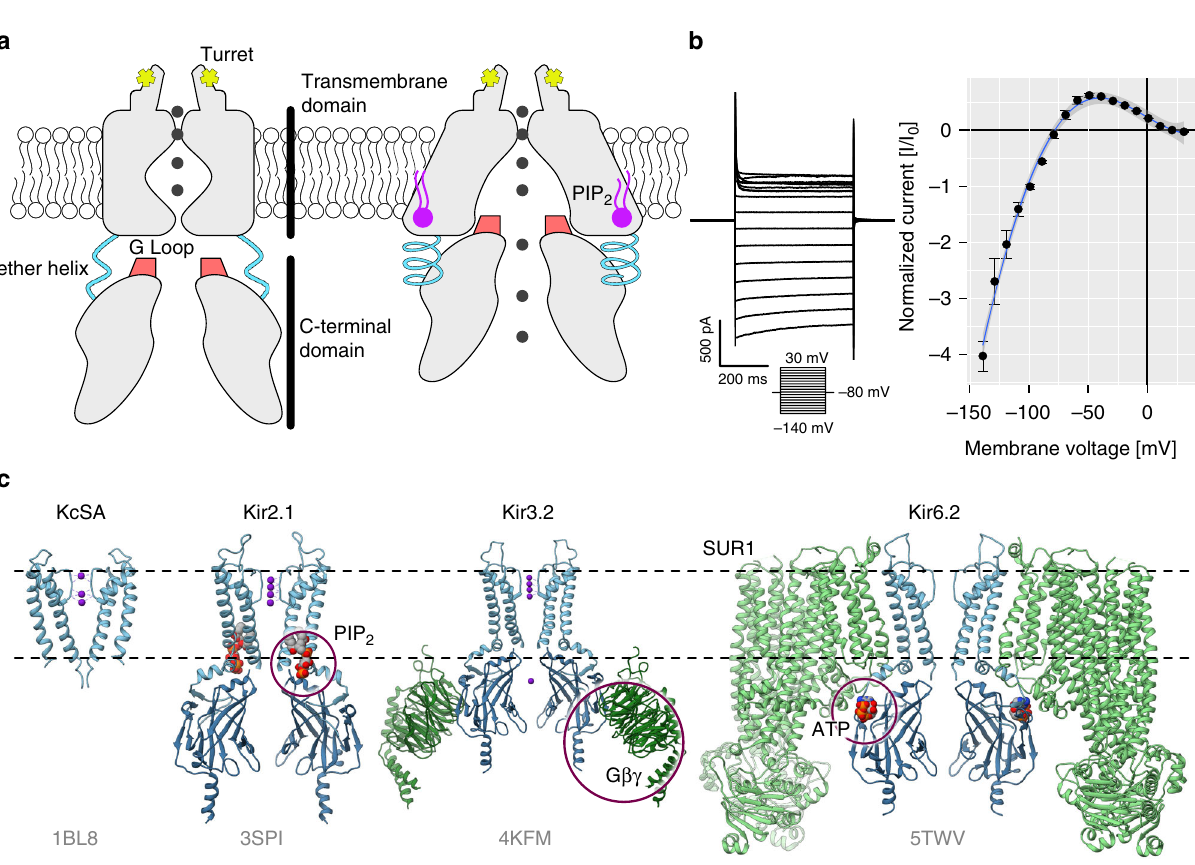
Fig. 1 Inward recti fi er K + channels. a Domain architecture of Kir2.1 in the closed (left) and open conformations (right). The C-terminal domain (CTD) is connected to the transmembrane domain (TMD) via a tether helix (light blue). Upon binding of PIP 2 (purple) at the interface between TMD and CTD, the tether helix undergoes a disorder-to-order transition and brings both domains closer together. The G-loop is wedged into the TMD causing the inner helix gate to open. Adapted from ref. 37 . b Whole-cell patch clamp electrophysiology of WT Kir2.1 transiently expressed in HEK293FT cells. A representative recording (left) and normalized currents (right) show strong inward recti fi cation ( ± s.e.m., n = 4). c A comparison between KcSA and representative structures of the inward recti fi er K + channel family (PDB accession codes are shown in gray) reveals that overall domain architecture is conserved. Channels are shown as blue and accessory protein as green ribbons. Allosteric modulators are indicated with purple